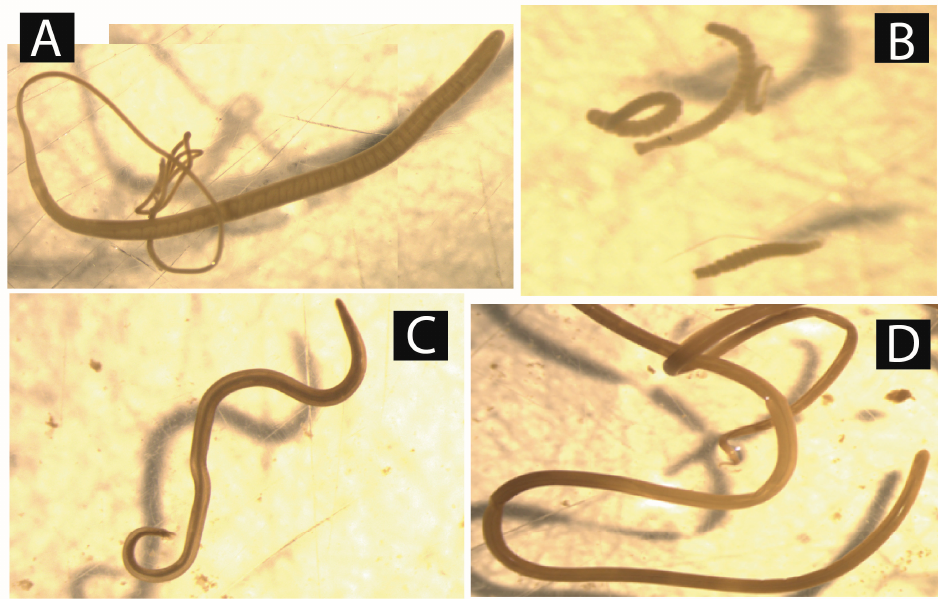
Figure 3. Micrographs of gastrointestinal parasite specimens isolated from different bushmeat in the Zadie department. ( A ) Trichuris spp.; ( B ) Taenia spp.; ( C ) Toxocara spp.; ( D ) Ascaris spp.